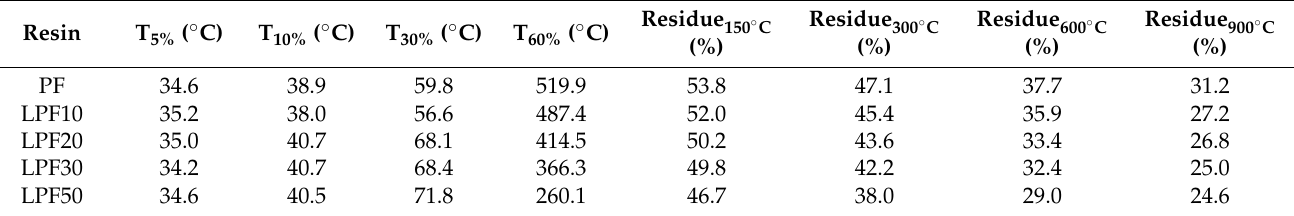
Table 4. Values of TGA analysis for different